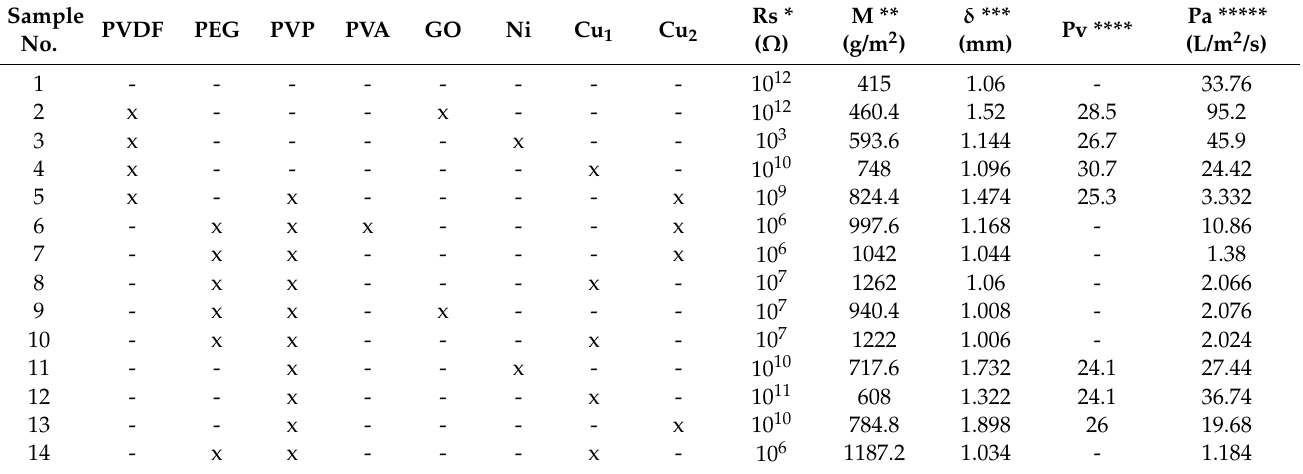
Table 1. Physico-mechanical and electrical properties of the electrodes-based polymeric membranes with metallic microparticles (Ni, Cu 1 , Cu 2 ) and GO.